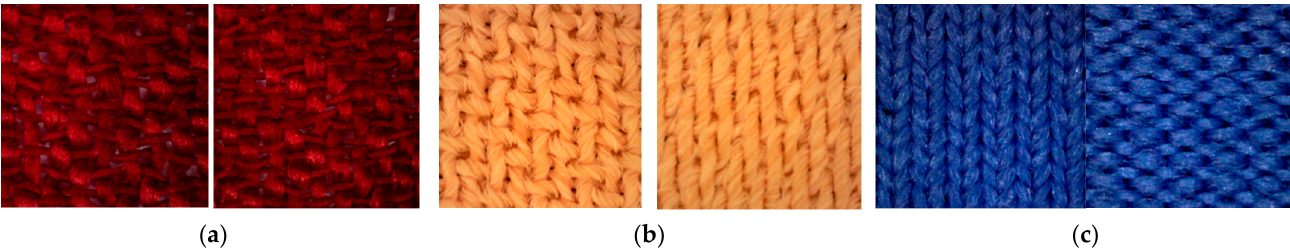
Figure 1. Images of three specimens with different fabric constructions taken by an image analyzer. ( a ) Plain-woven fabric; ( b ) twill-woven fabric; and ( c ) plain knit.